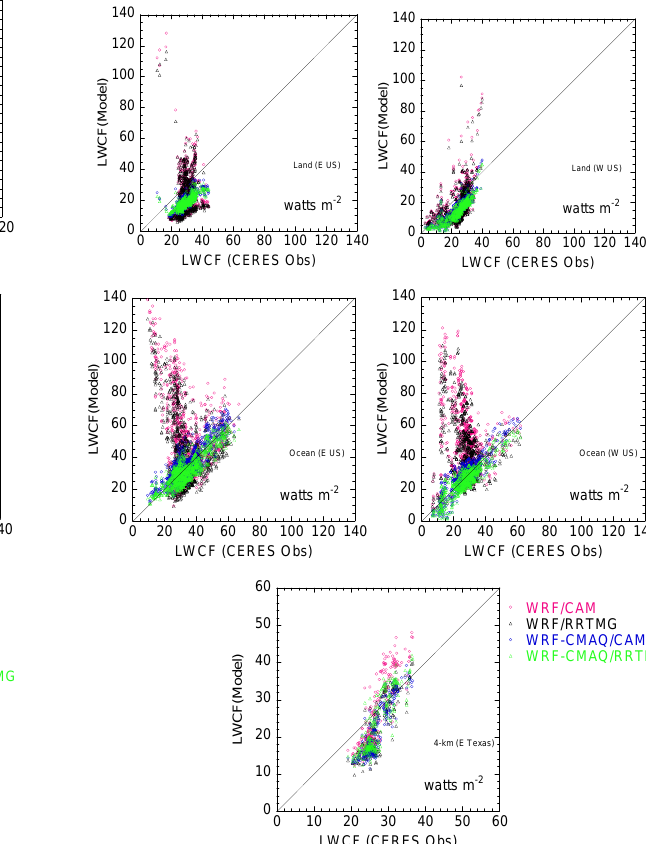
Figure 15. Same as Figure 11 but for LWCF.